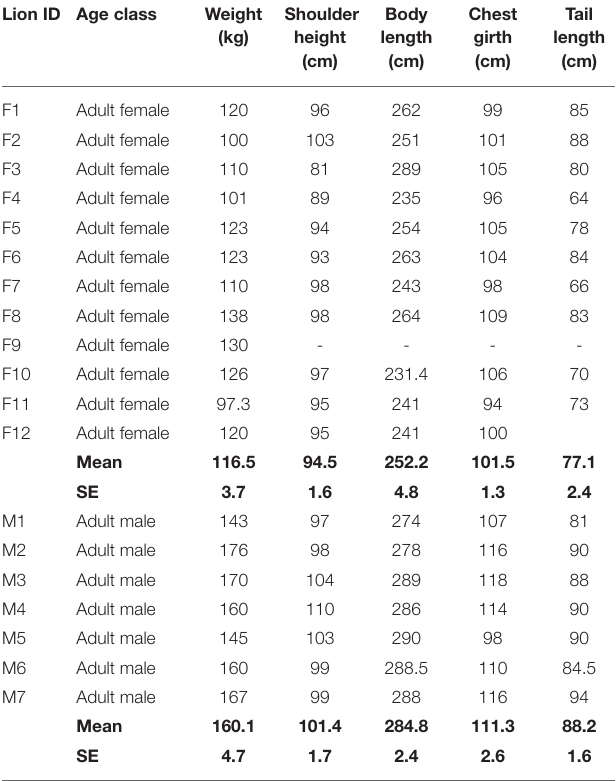
TABLE 1 | Morphometric details of adult Asiatic lions ( n = 19; 12F, 7M) captured between 2001 and 2018 for deploying radio-collars. Body length is measured from nose-tip to tail-tip along the